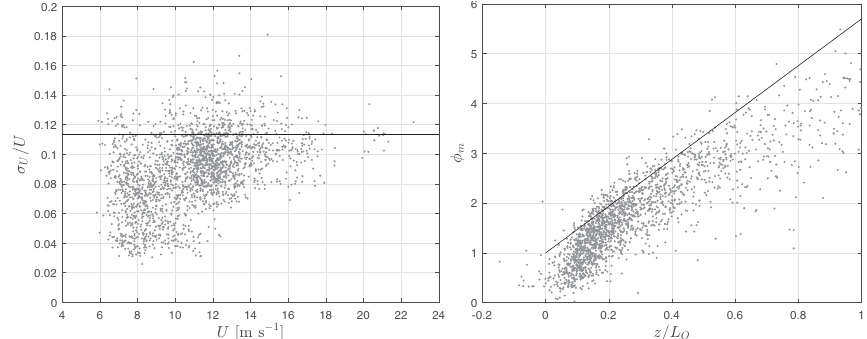
measurementsat78and56mtoestimate ( )andthesonic-derived tocompute and .Figure13-right shows that the atmosphere during the analyzed period is mostly stable ( ) and that, as expected, increases with increasing . Such atmospheric conditions explain the low values for low wind speeds. In Fig. 13-left, we include a prediction of using Eqn. (13) with and m, which fairly agrees with the data for high wind speeds only, as expected. In Fig. 13-right, we include, for comparison only, the prediction from surface- 5 layer theory (Högström, 1988) that is offset with the data because , and so , are estimated at a mean height of Figure 12. Examples of normalized Doppler radial velocity spectra measured over five 10min periods with the ZephIR at the positions of m with only two wind-speed observations 22-m apart, whereas the turbulence estimates are from the sonic anemometer at 76 bin 0 (left) and bin 31 (right). The markers show the observed distributions and the solid lines show a normal fit. m.